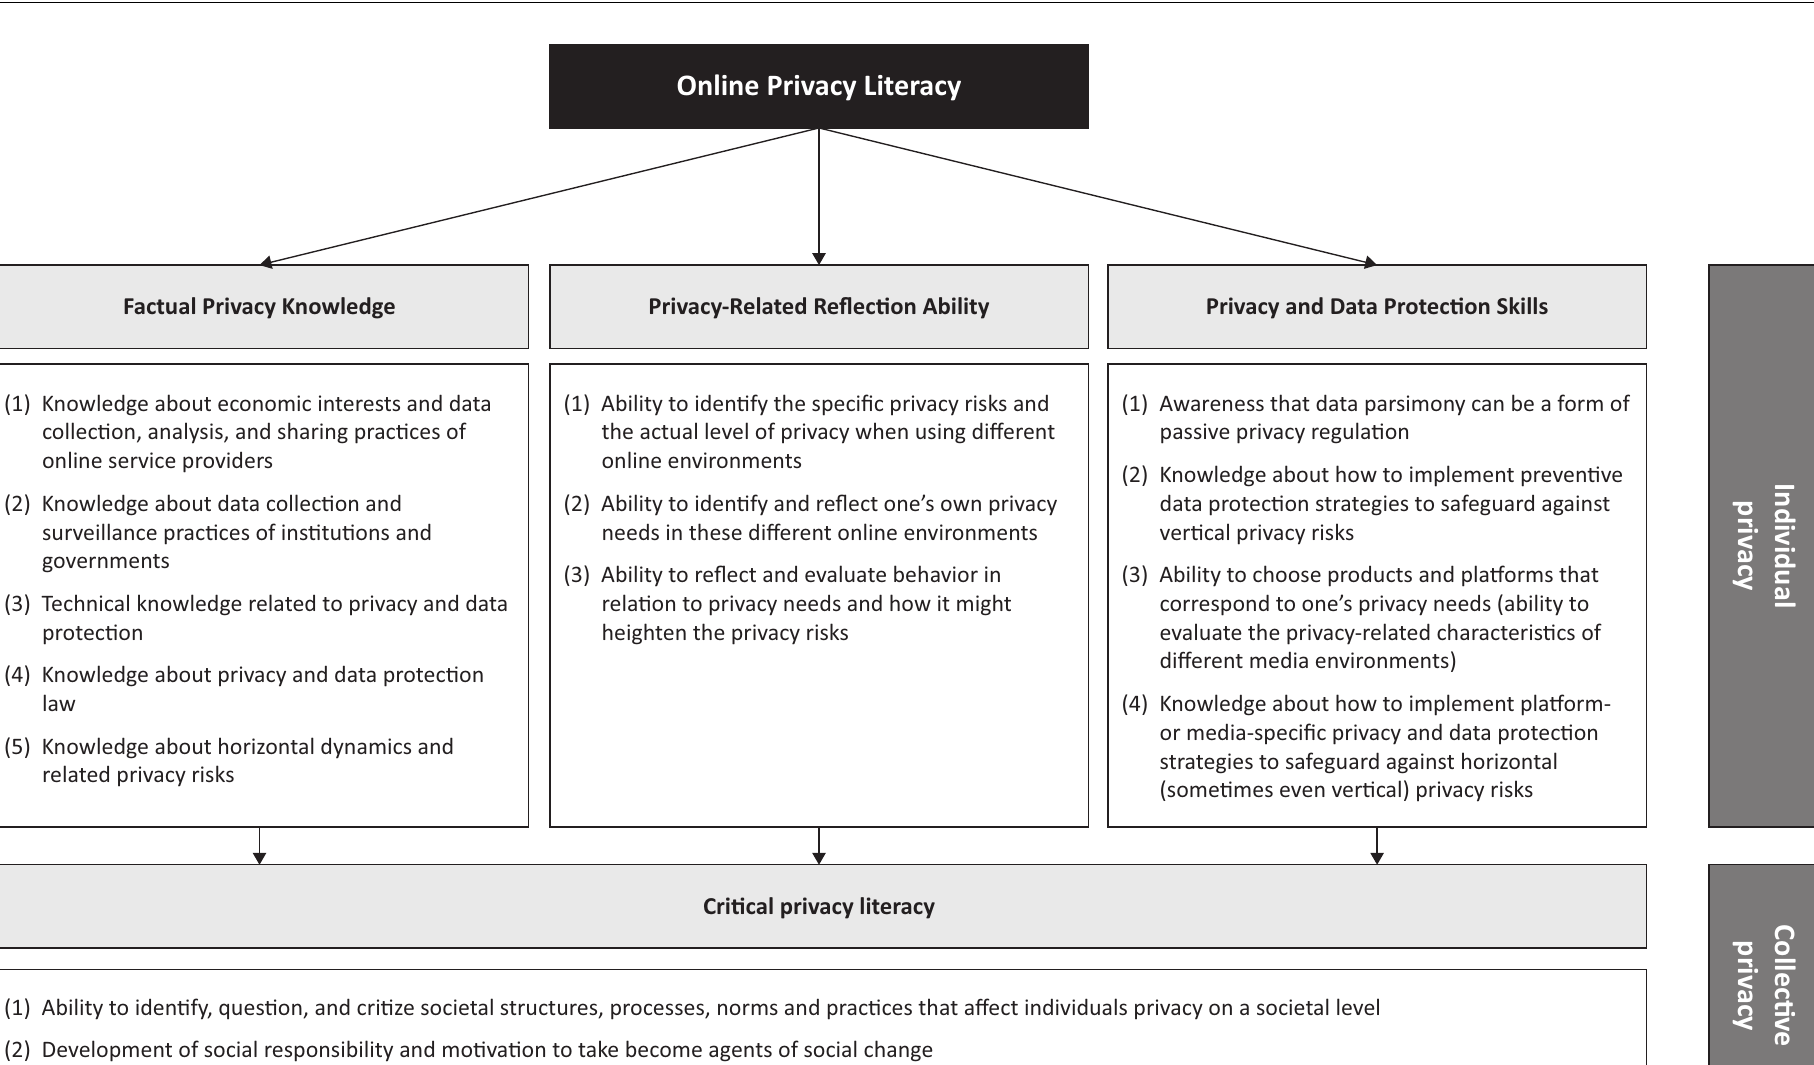
Figure 1. A comprehensive model of online privacy